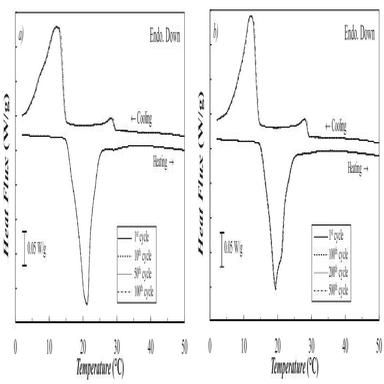
Cooling− heating cycling tests for the aqueous nanoemulsion loaded with 12 wt% of the optimized C18Me:C16:C14Me dispersed phase (a) one day after the preparation and (b) 8 months after preparation. DSC curves obtained at β = 10 ◦C/min from different runs are mainly superimposed.